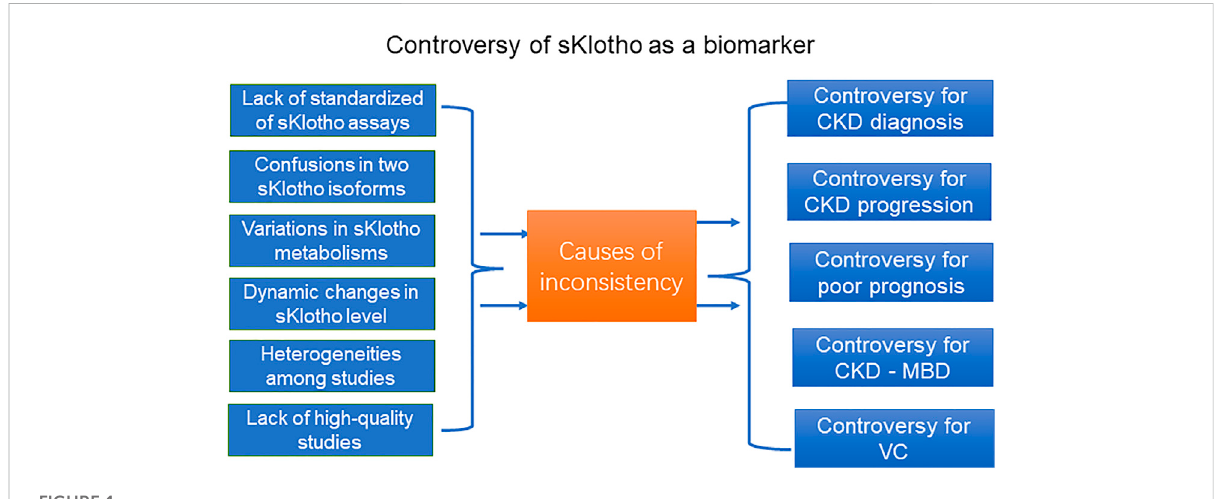
FIGURE 1 The controversy of sKlotho as a biomarker in